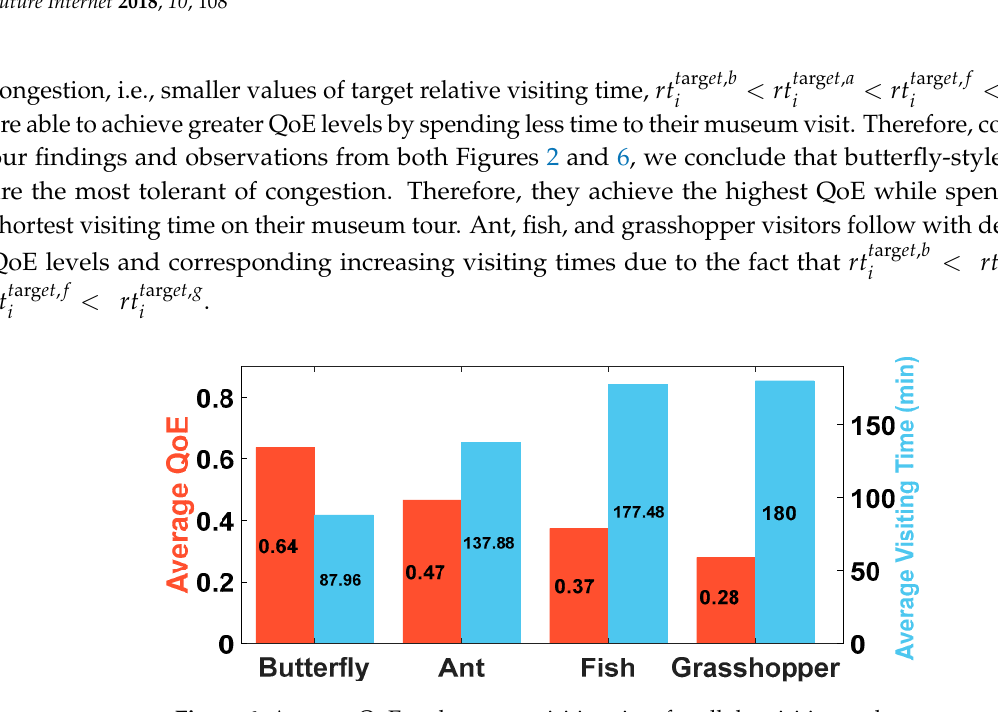
Figure 5. Distribution of the visitors for the recommendations for all the visiting styles.